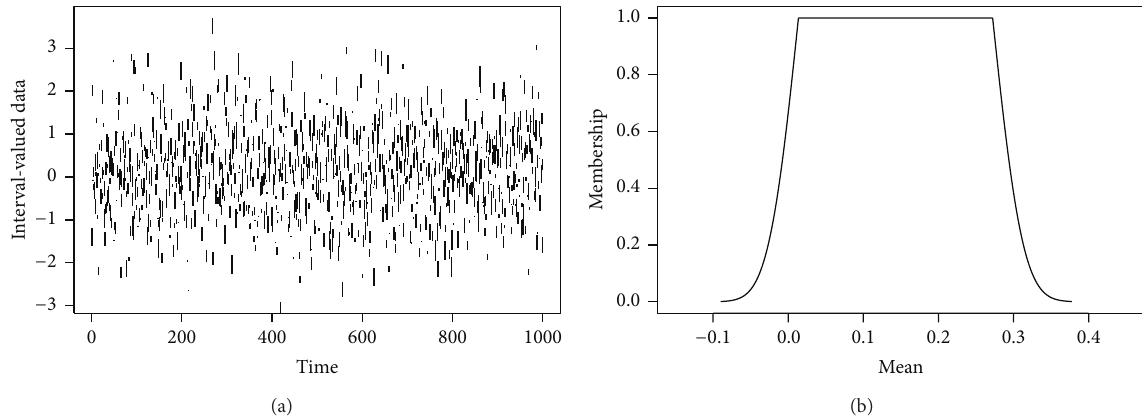
Figure 1: Fuzzy representation of LQD. (a) 1000 instances of an interval-valued database. (b) Fuzzy (possibilistic) representation of the mean value of the data in the left part. 𝛼 -cuts of this fuzzy set are bootstrap-based confidence intervals of the interval valued data; that is, they are the smallest intervals containing at least a fraction 1 − 𝛼 of the